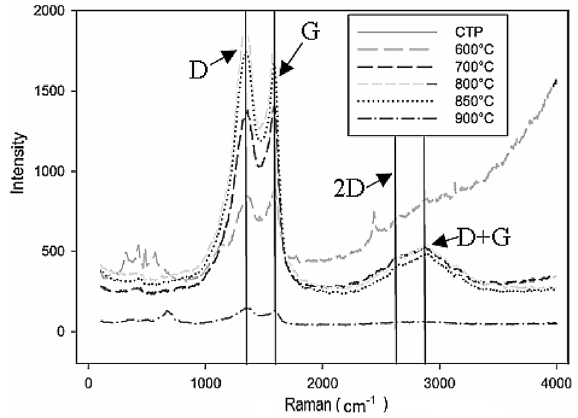
Fig. 4 RS results for a sample of solids obtained at 700 (cid:3) C